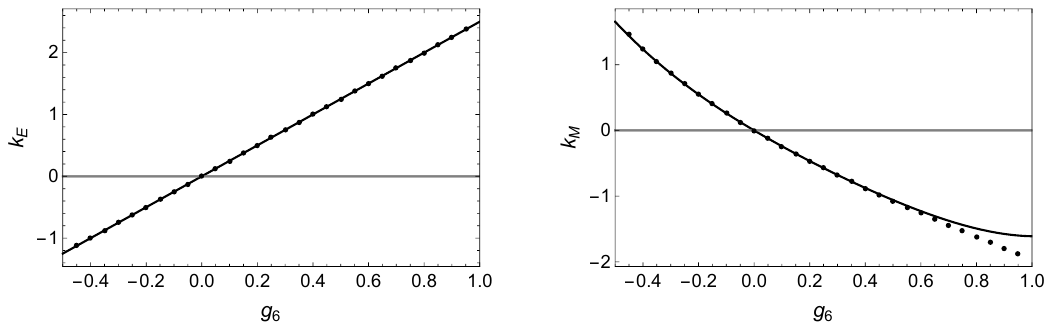
Figure 8 . Dipolar electric (left) and magnetic (right) susceptibilities as functions of the non-minimal coupling g 6 . Dots are the numerical results, solid lines correspond to the analytical approximations in eq.